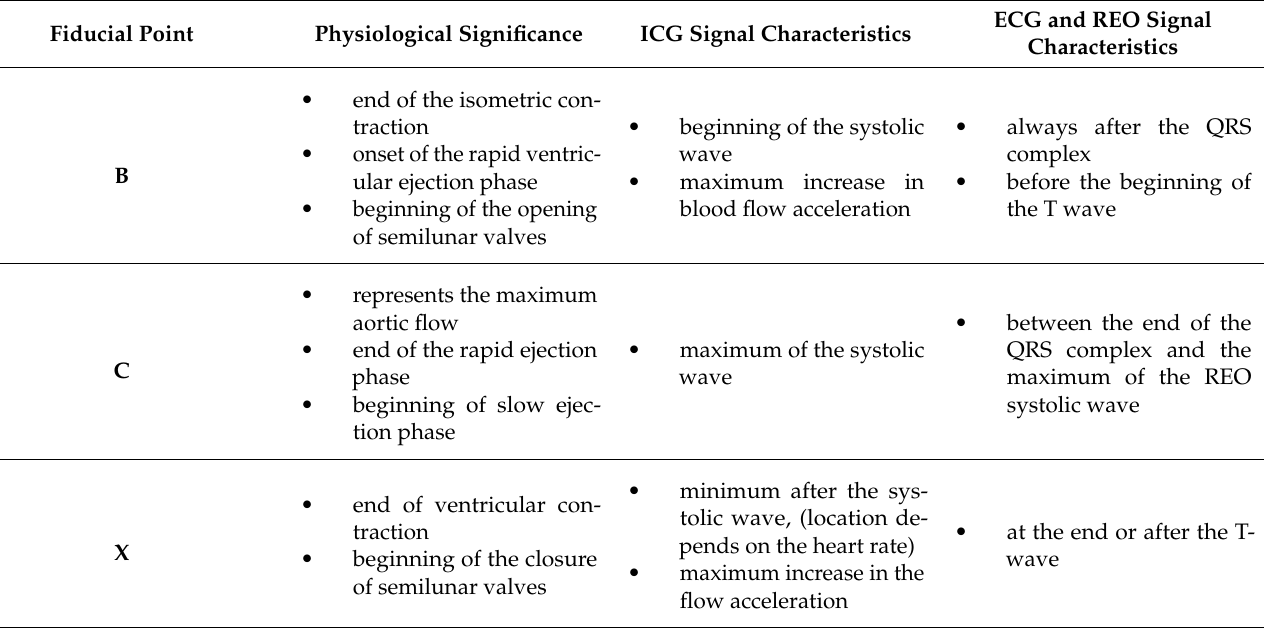
Table 1. The characteristic points in the ICG signal, their physiological relevance and reference to ECG and